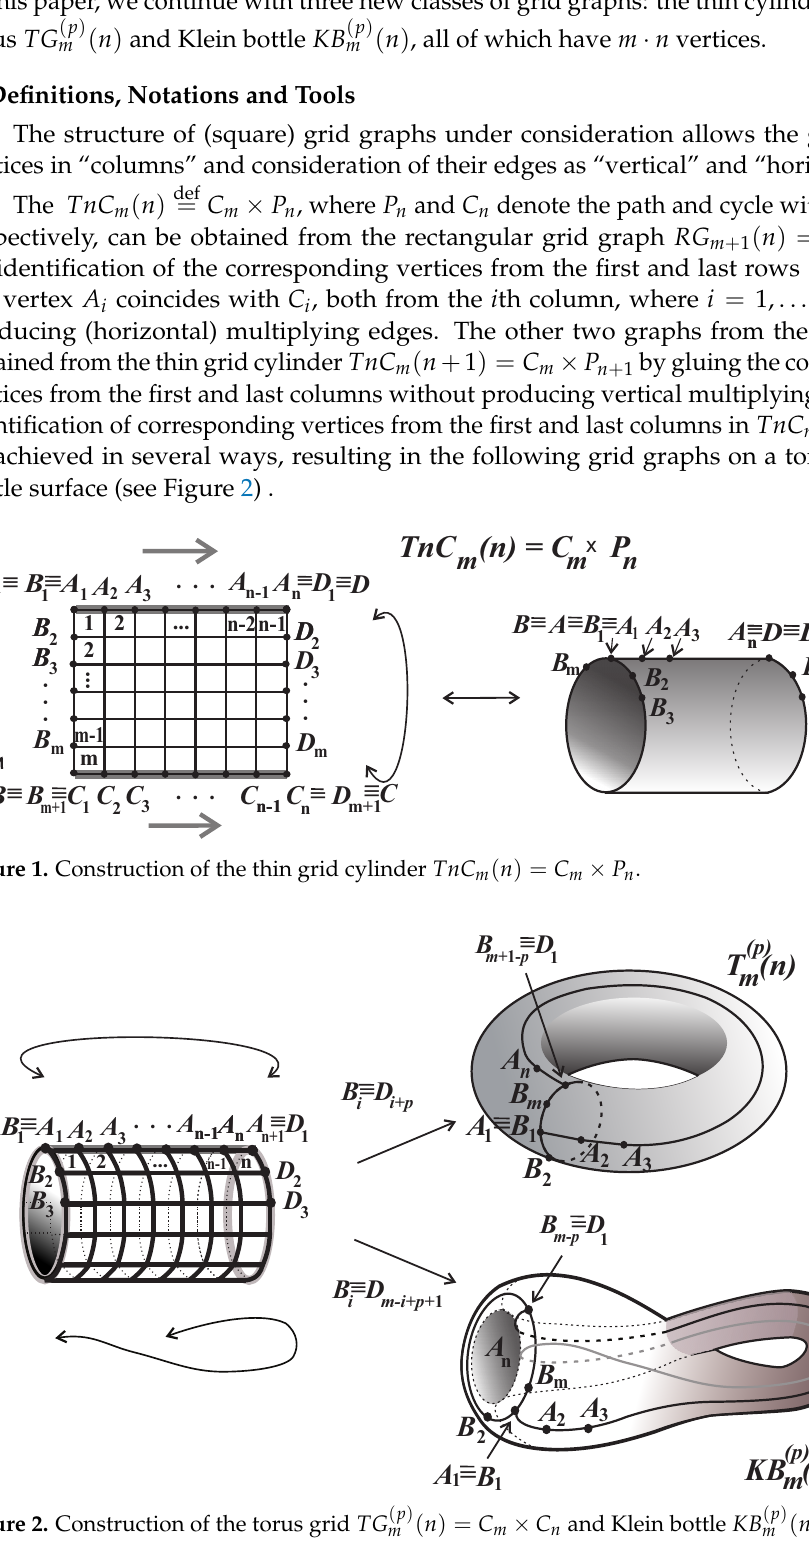
Figure 2. Construction of the torus grid TG